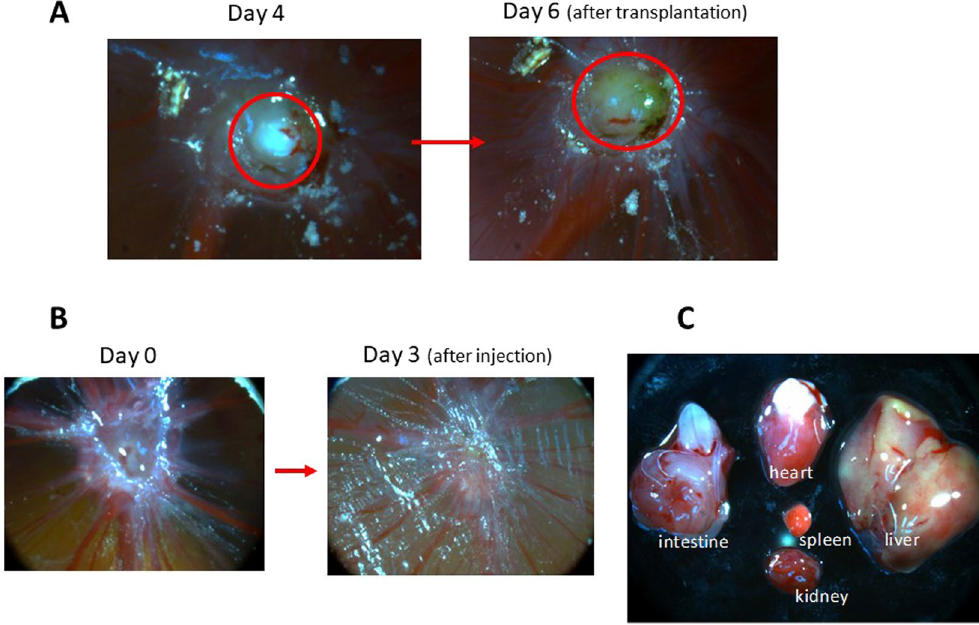
Figure 8. Patient tumor sample transplanted on the CAM membrane. ( A ) Tumor formed by transplanting minced sample of ovarian cancer patient tumor. ( B ) Tumor is eliminated after intravenous injection of PMO-1 containing doxorubicin. ( C ) Chick embryo major organs look normal three days after